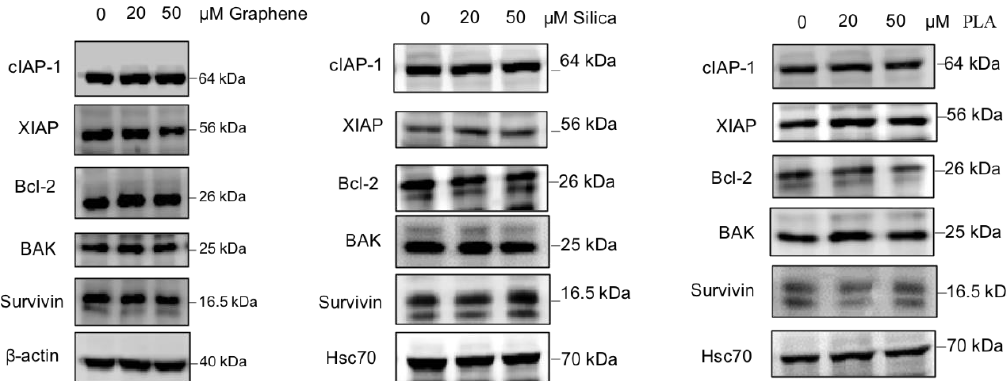
Figure 4. Expression pattern of proteins related to drug resistance in nanopolymer-treated MDA-MB-231 cells. MDA-MB-231 cells were treated with graphene quantum dots (GQDs), mesoporous silica nanoparticles (MSN), polymeric lactic acid (PLA) during 24 h and expression of c-IAP1, XIAP, Bcl-2, BAK and Survivin proteins were analyzed by Western blotting. Hsc70 or β -actin was used as an internal control. The blots are representative of three independent experiments.